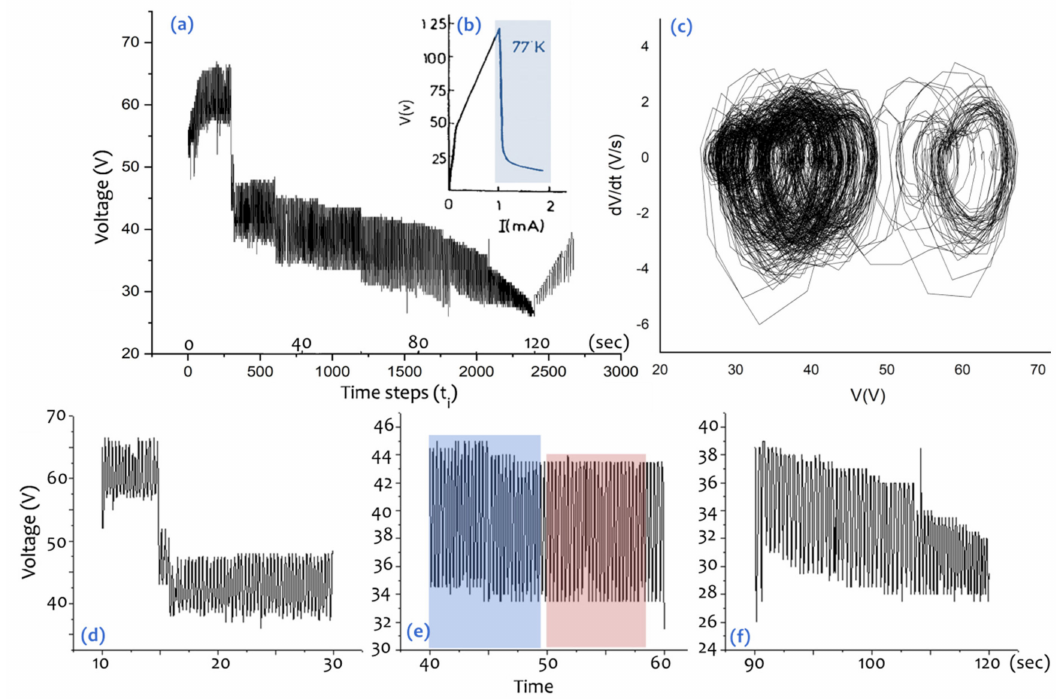
Figure 1. ( a ) The available time-series expressing typical voltage oscillations as monitored in the negative-di ff erential-resistance (NDR) region of ( b ) a representative current-voltage ( I - V ) characteristic as registered on TlInTe 2 , at an ambient temperature 77 K and for a fixed current value I = 1.15 mA (marked by the blue area), ( c ) The phase portrait of voltage oscillations, ( d ) part of chaotic oscillations in the time-series, ( e ) a semi-periodic section in the NDR region, ranging from 40 to 49 s (blue area), and a periodic one, ranging from time t = 50 s to t = 57 s (red area), ( f ) part of chaotic oscillations in the time-series (source: